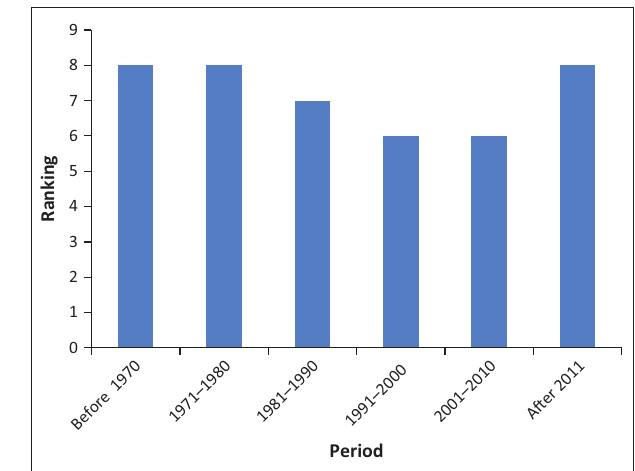
FIGURE 3: Perceived temperature and rainfall trends 1960–2014: ward